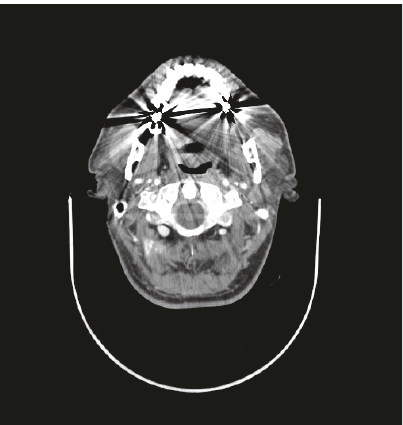
Figure 1: CT scan with contrast axial view. Despite severe metal streak artefacts due to presence of amalgam, a homogenous enhancing lesion measuring about 17 ∗ 15 mm is demonstrated in the deep portion of left parotid gland.